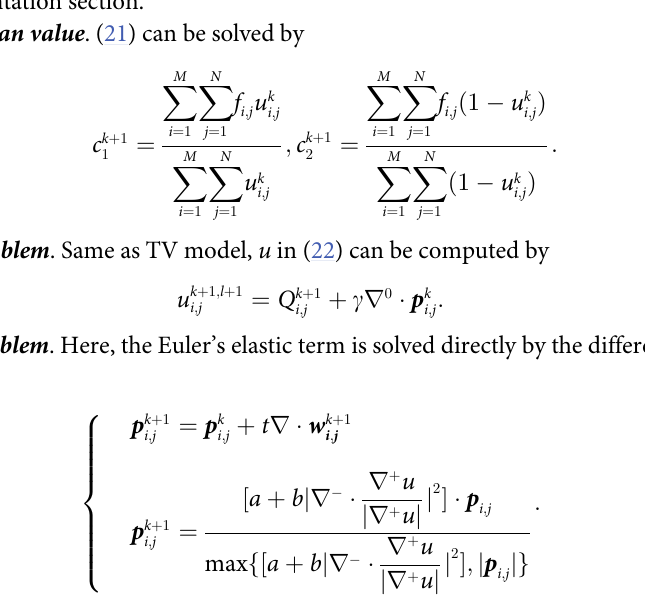
Algorithm 3 is the summary of the dual elastica segmentation method. Algorithm 3 : Dual elastica for